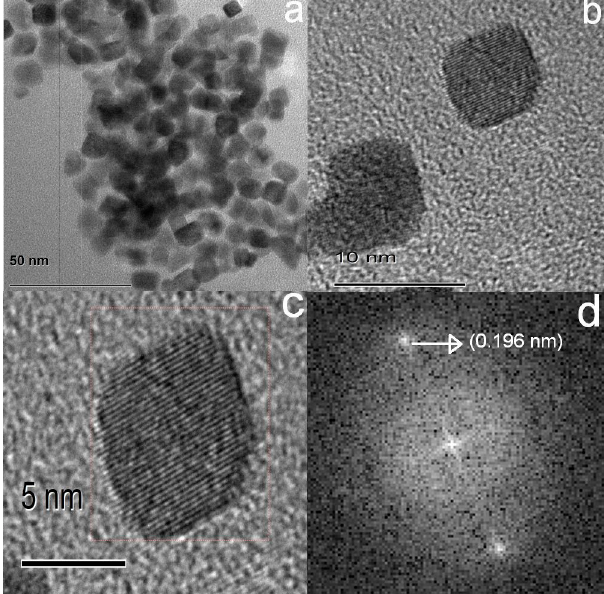
Figure 1. (HR-)TEM micrographs of cubic (c) Pt NPs: ( a ) overview; ( b , c ) HR-TEM; and ( d ) FFT pattern. Catalysts 2020 , 10 , x FOR PEER REVIEW